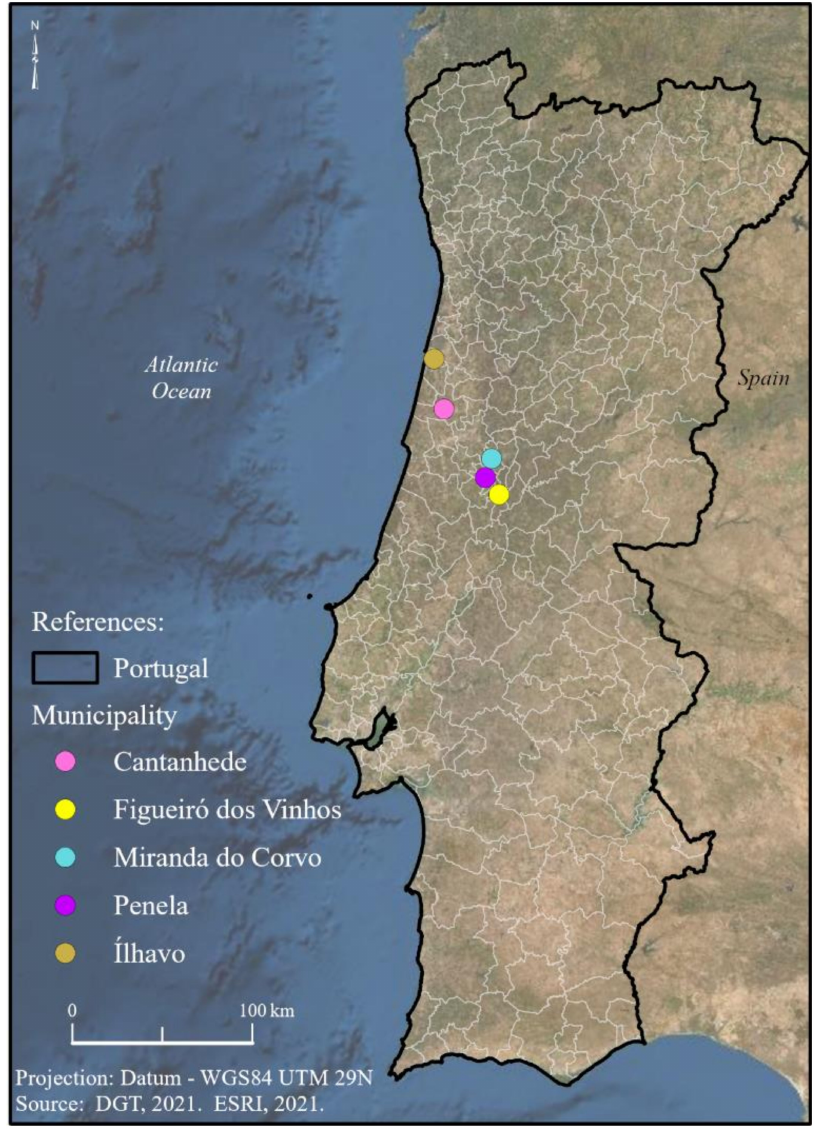
Figure 1. Localization of the selected five